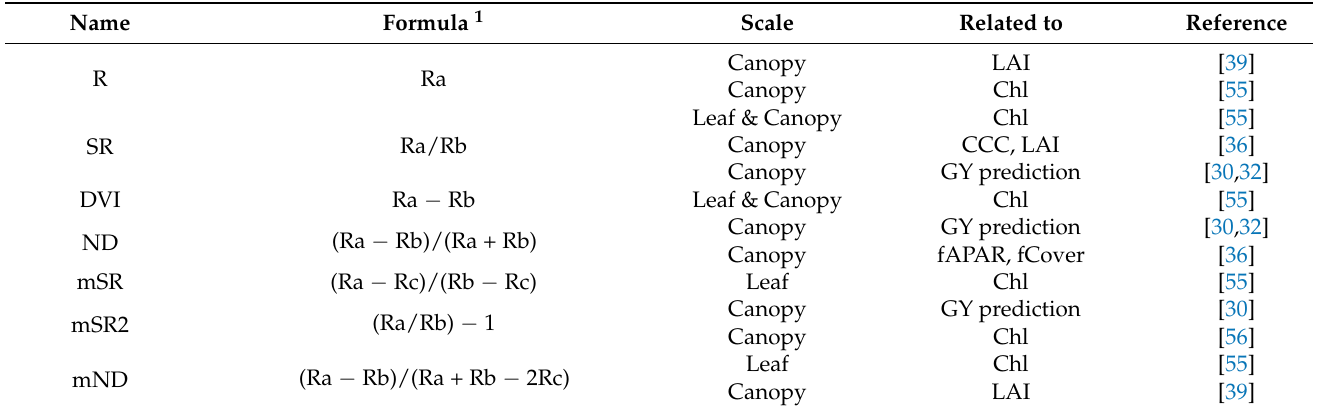
Table 6. List of the generic types of vegetation indices selected for testing in the